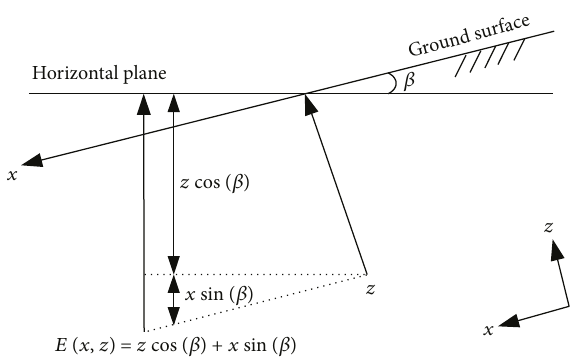
Figure 1: The de fi nition of the elevation head in an unsaturated inclined